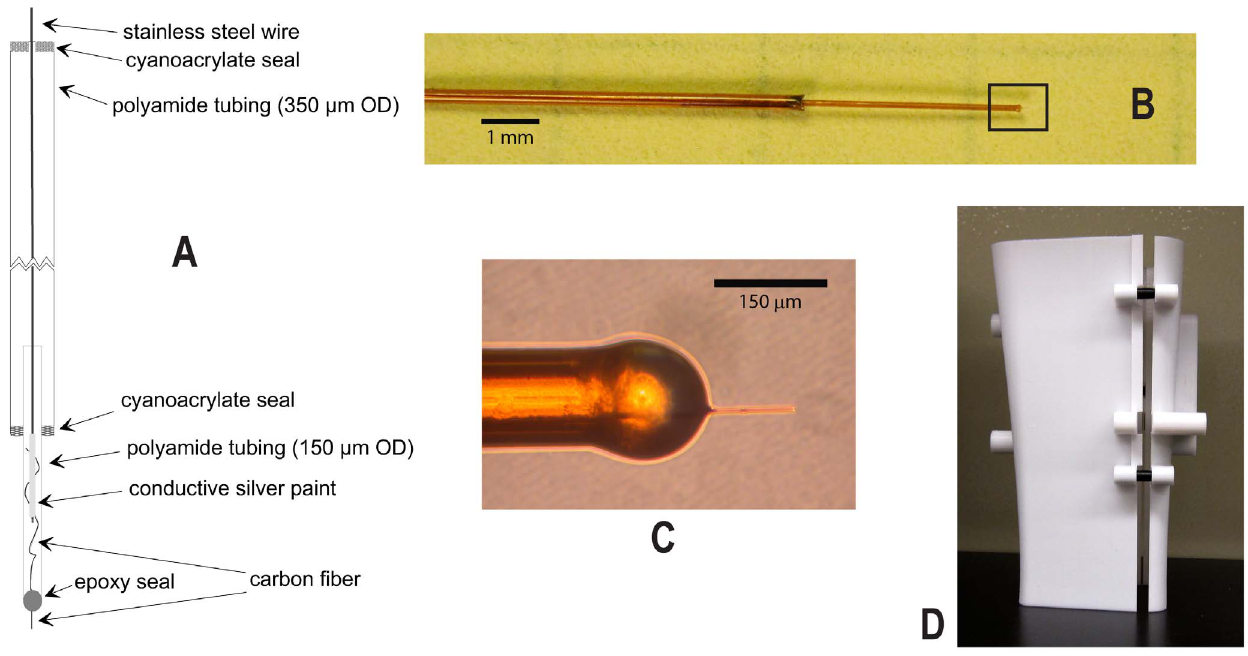
Figure 3. Carbon fiber electrode and printed Faraday shield. (A) Schematic of carbon fiber electrode construction. The 7 m m carbon fiber is electrically connected to a 51 m m (.002 in) diameter stainless steel wire using silver paint. Cyanoacrylate and epoxy provide seals for the two different size polyimide-coated silica capillary tubing. (B) Photograph of the carbon fiber electrode centered near junction of large and small tubes. (C) Expanded region of the black outlined square in tile B is a photomicrograph of exposed carbon fiber and epoxy seal. (D) Two-part Faraday shield. Each side of the clamshell shield was printed on a plastic printer. Plastic alignment pins (in black) and retaining screws (not shown) were added after printing. Base of shield closely fits the dimensions of the microdrive base and chamber (see Fig. 1), providing clearance for the posterior head post. The upper portion is wider to accommodate connections to the microdrive towers. The smaller section is held fixed and the larger section is removable. Photo taken before the application of conductive